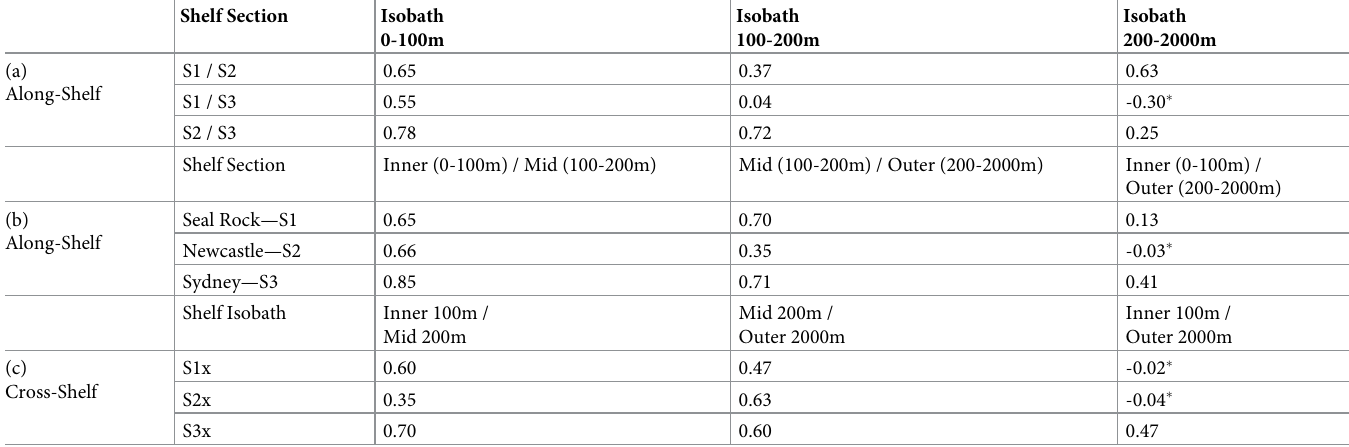
Table 2. Correlation coefficients of transport between shelf sections. Shelf